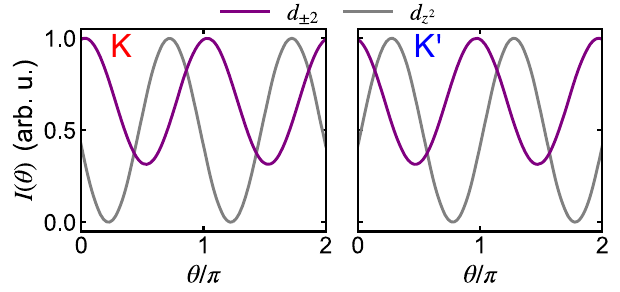
FIG. 7. Valley-integrated orbital-resolved photoemission inten- θ Þ (analogous to Fig. 3) around the K and K 0 points, sity I m ð respectively [same as in Fig. 3(a)], for m denoting the d d orbital. The intensity has been normalized to the respective z 2